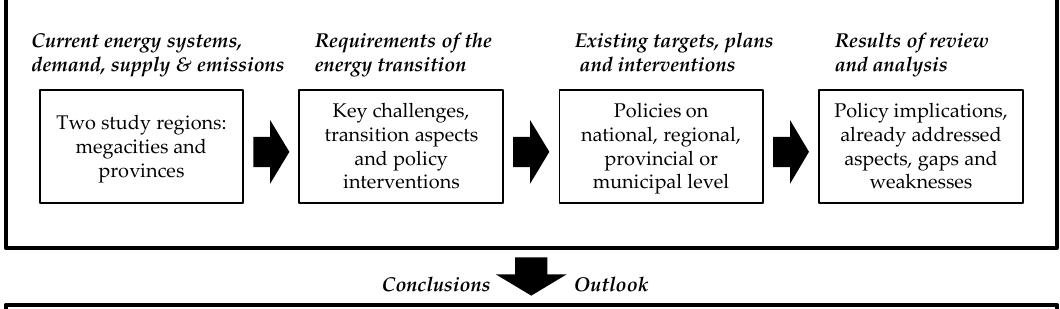
Figure 1. Overview of the methodological approach for the policy analysis.